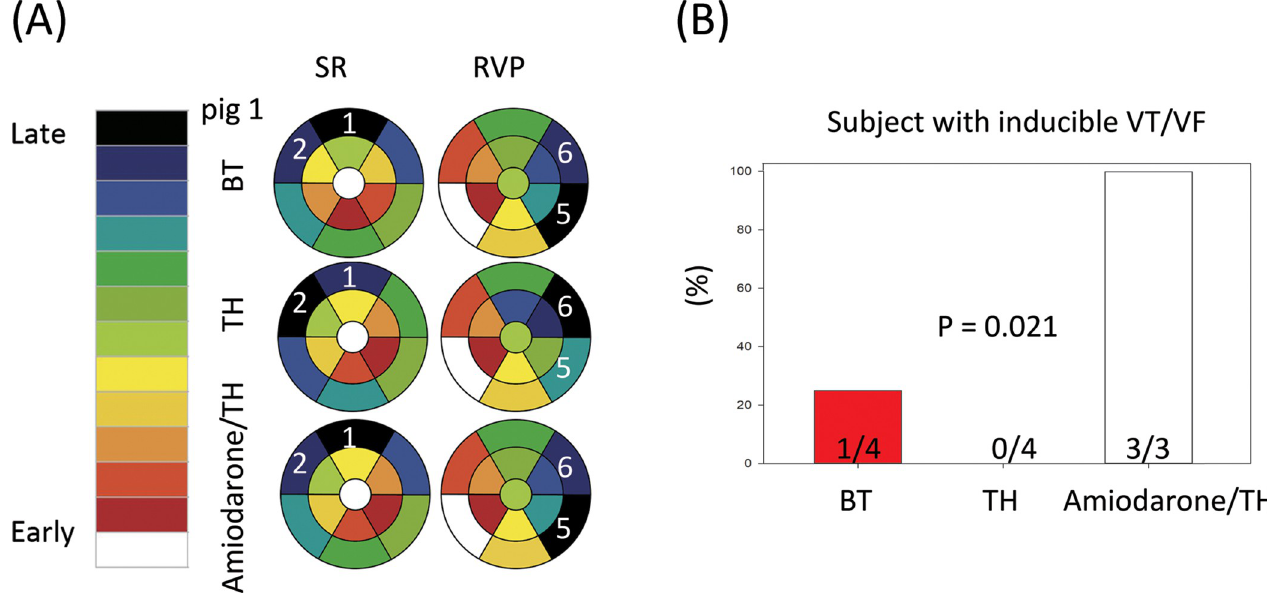
Fig 5. Changes in the wavelet activation pattern, the vulnerability to ventricular arrhythmias after amiodarone treatment during TH, and Regional differences in the connexin 43 expression during TH and amiodarone treatment. (A) Representative isochronal activation from pig 1 according to the pre- specified segments. During SR, the earliest activated site was the apical area (segment 13), and the latest activated site was the outflow tract area (segment 1) at BT. After TH, the latest activated site changed to the anterior basal RV (segment 2). After amiodarone infusion during TH, the latest activated site moved back to the outflow tract area (segment 1). During RVP, the earliest activated site was the posterior basal right ventricle (segment 3), and the latest activated site was mostly (83.3%) the posterior basal LV (segment 5) at BT. At TH, the latest activated site mostly changed to the anterior basal LV (segment 6, 66.7%). At amiodarone/TH, the latest activated site moved to the posterior basal LV (segment 5, 50%) in half of the pigs. (B) The incidence of ventricular arrhythmias after burst RVP. The vulnerability to ventricular arrhythmias was tested in 4, 4, and 3 pigs with BT, TH, and amiodarone/TH respectively. The vulnerability to ventricular arrhythmias of pigs with amiodarone/TH group was higher than the pigs at BT and the pigs with TH (P = 0.021).